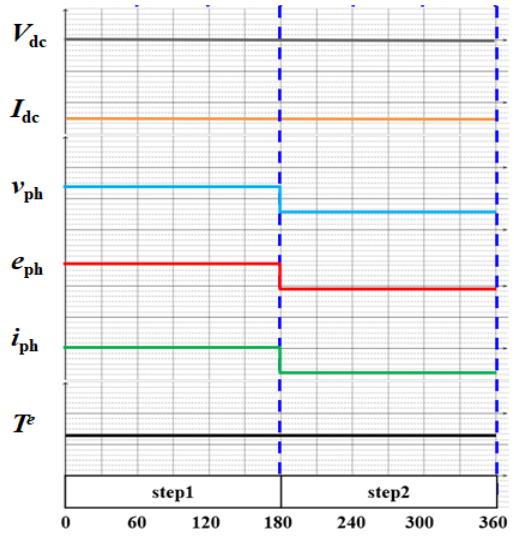
Figure 1. Relationship between parameters of a single-phase BLDC motor in ideal conditions.